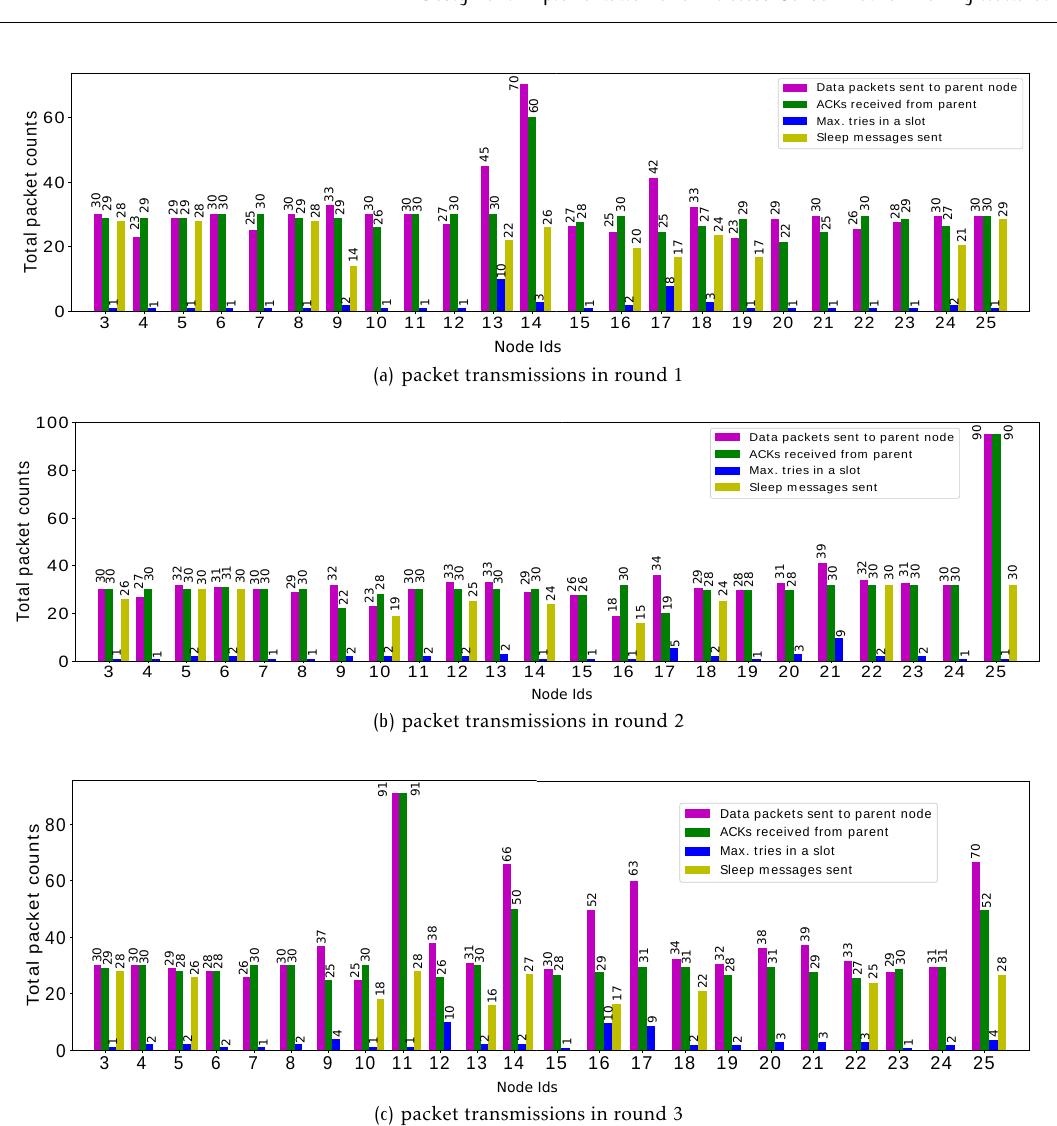
Figure 26. Comprehensive packet analysis from the snooper nodes for test case